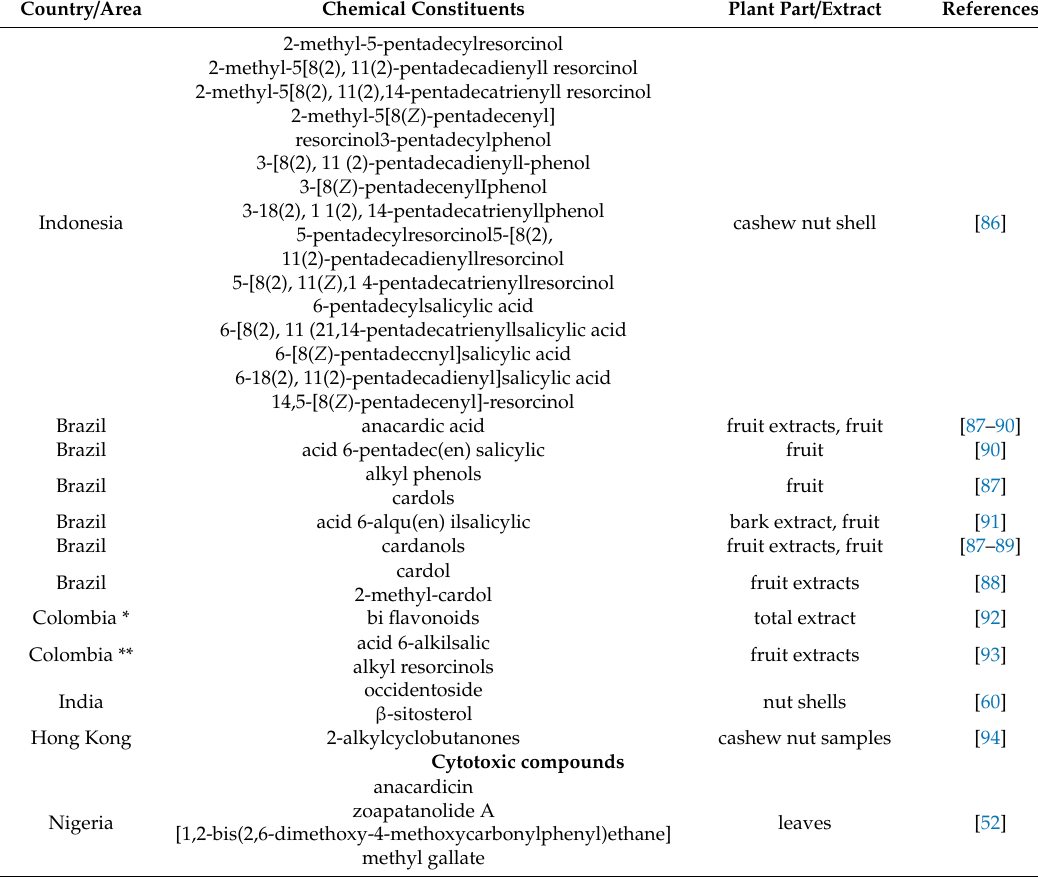
Table 9. Other phytochemicals present in Anacordium occidentale